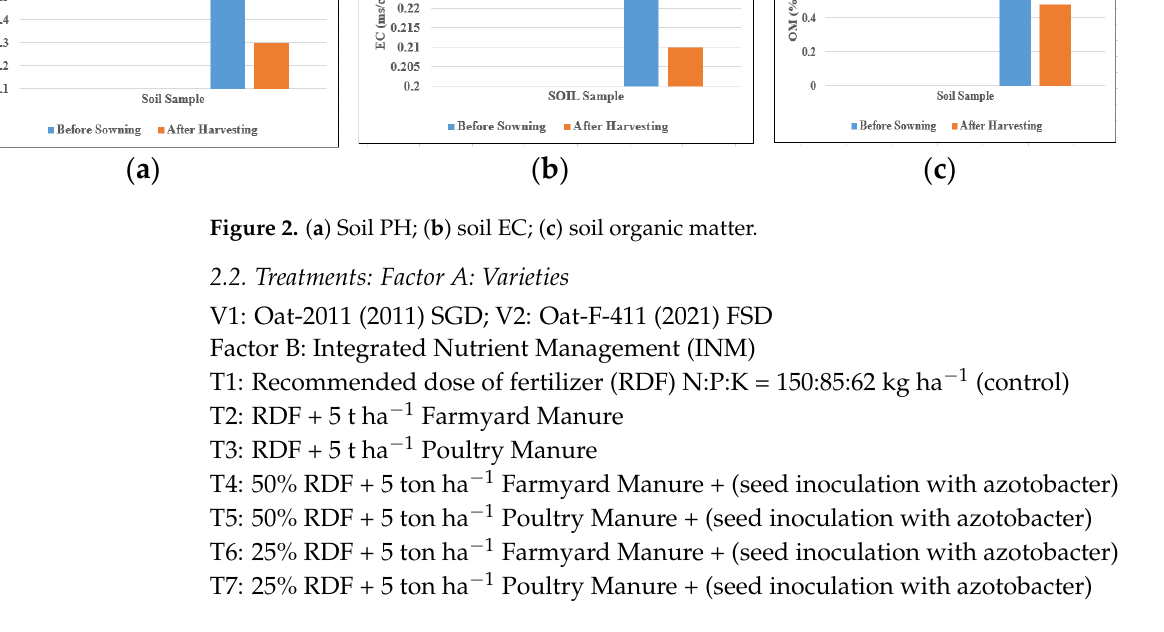
Figure 2. ( a ) Soil PH; ( b ) soil EC; ( c ) soil organic matter.